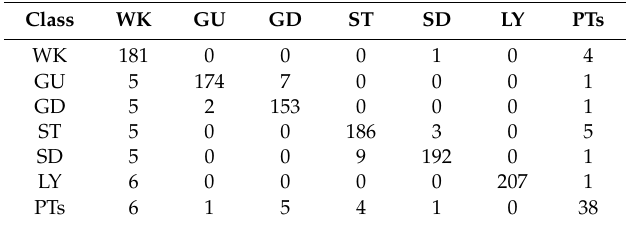
Table 13. Confusion matrix for the simultaneous classification of six actions.